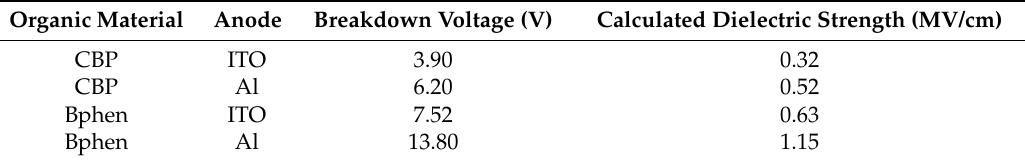
Table 1. Tabulation of the used anode, observed breakdown voltage, and calculated dielectric strength for the deposited 120 nm thickness of the organic layer.